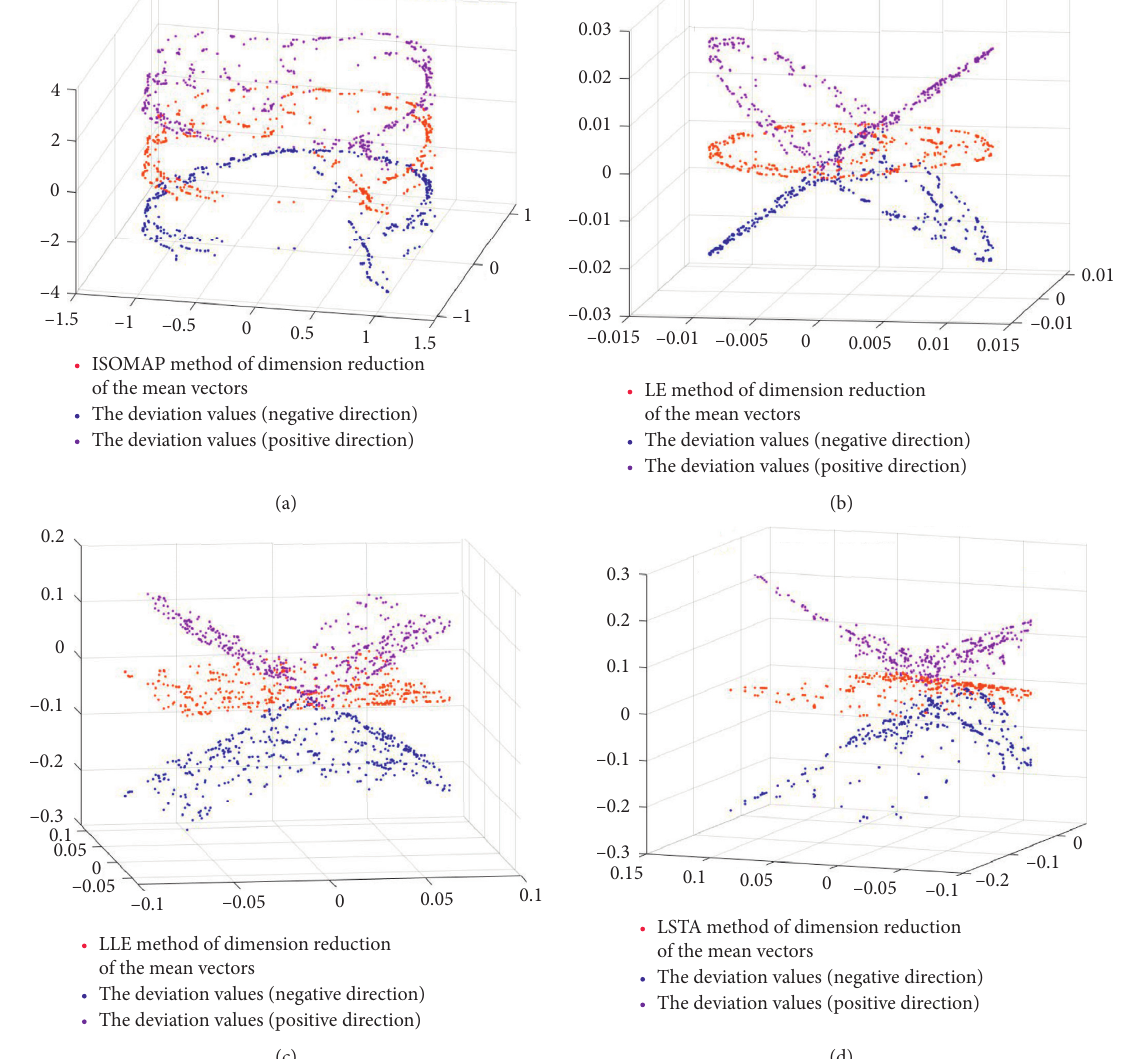
Figure 7: Dimension reduction of the mean vectors and deviation values in low-dimensional space of each anchor experiment. Figure 17 is an example of the original image.